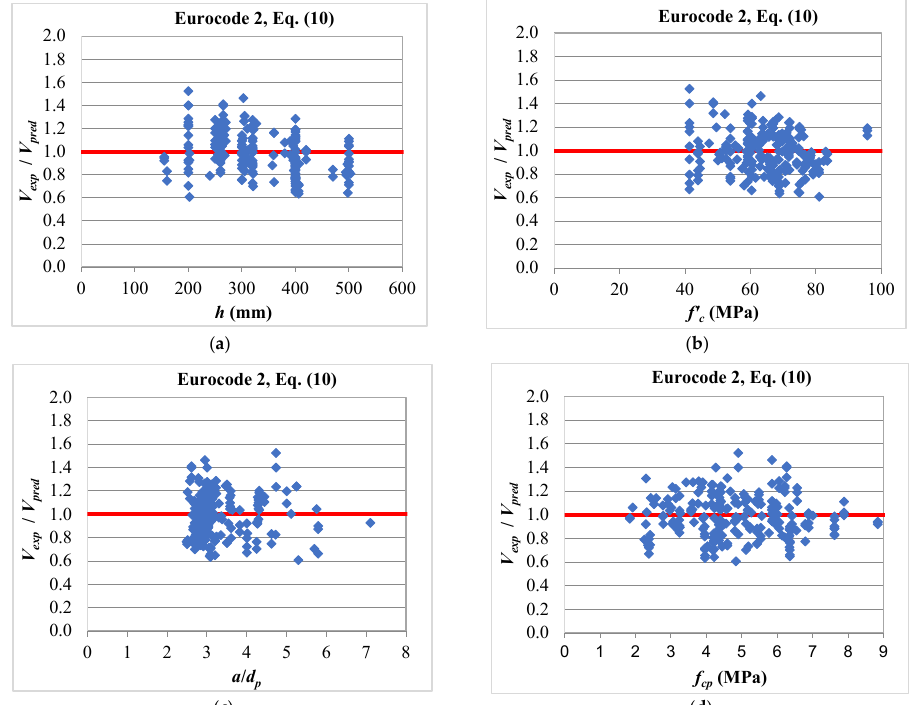
Figure 7. Predictions of the Eurocode 2 design equation against ( a ) total thickness, ( b ) concrete compressive strength, ( c ) shear span to depth ratio, and ( d ) compressive stress due to the fully effective prestressing force.